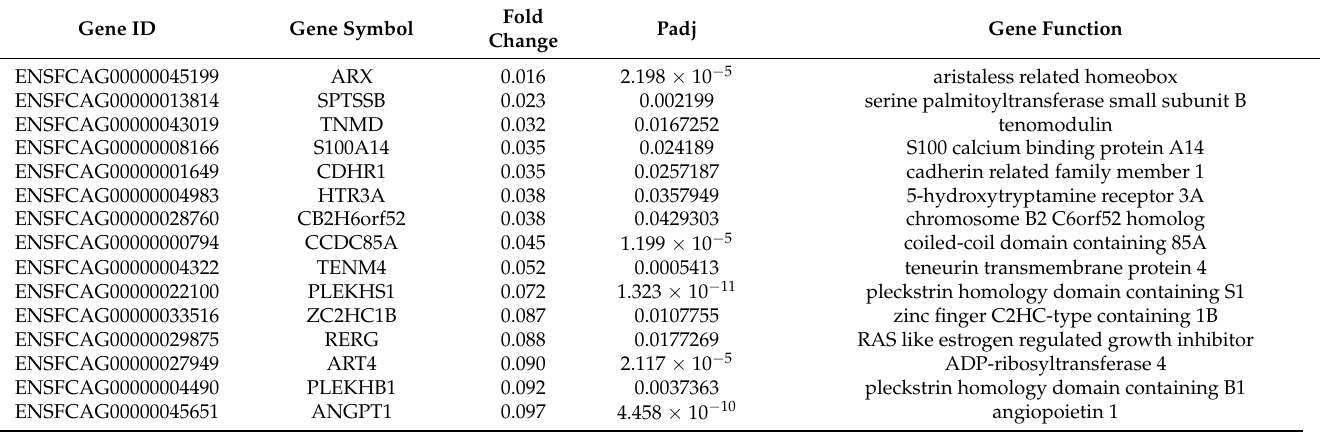
Figure 7. Analysis of RNA sequencing of CRFK cells sensitized with naïve fADSC-CM ( A ) Boxplot of the expression values for each sample. ( B ) PCA plot of samples. ( C ) Heatmap of expression similarity among samples. ( D ) Volcano plot of each group. Magenta dots indicate upregulated genes and green dots indicate downregulated genes in CRFK treated with fADSC-CM, according to adjusted p -value < 0.05 and fold change > 2 or <0.5. ( E ) Heatmap of expression values of selected genes in each sample (showing only the first 100 genes). Samples 1–3, mock-treated CRFK cells; samples 4–6, CRFK cells treated with fADSC-CM. Table 3. Top 15 most highly downregulated genes ranked by decreasing fold change in